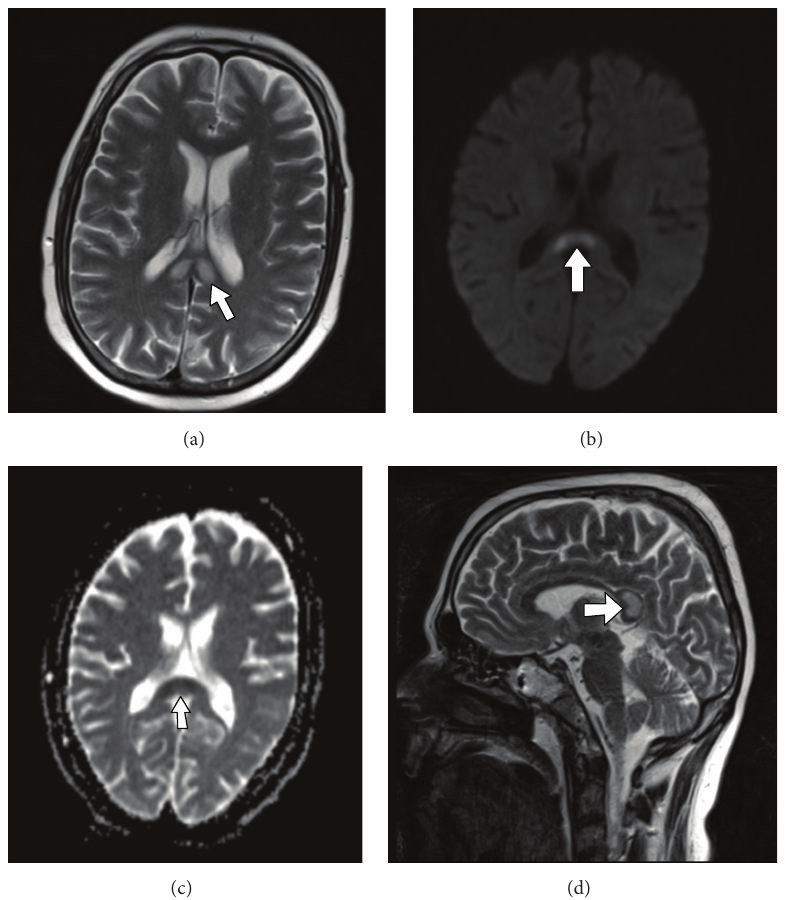
Figure 1: Axial T2-weighted brain MRI (a) shows increased signal in the splenium of corpus callosum (arrow in (a)). Diffusion weighted (DWI)(b)andADC-map(c)imagesshowrestricteddiffusionintheinvolvedareasofcorpuscallosum(arrowsin(a)and(b))thatisconsistent with necrosis. Sagittal T2-weighted image (d) shows sparing of the periphery of corpus